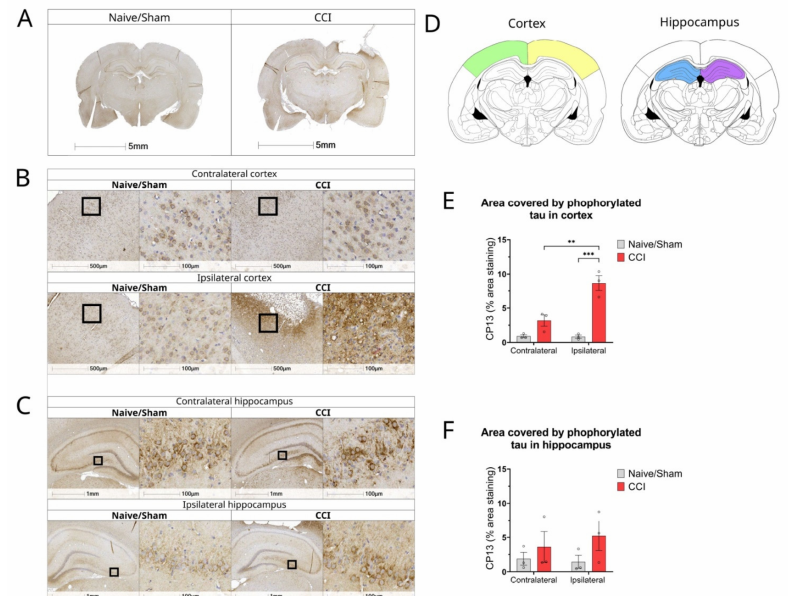
Figure 6. Tau expression is increased in cortex of CCI rat brains 2 weeks post-injury. ( A ) Rep- resentative whole brain photomicrographs of CP13 staining in naïve/control and CCI rat brains; ( B ) Magnified representative images of CP13 staining in cortex of naïve/sham animals and CCI brains from ipsilateral and contralateral sides of the injury; ( C ) Magnified representative images of CP13 staining in the hippocampus of naïve/sham animals and CCI brains from ipsilateral and contralateral sides of the injury; ( D ) Brain atlas images, showing areas of cortex and hippocampus analysed; ( E ) Quantification of CP13% area stained in the cortex of CCI and sham/naïve control rats (two-way ANOVA hemisphere F(1,8) = 14.68 p = 0.0050, injury F(1,8) = 51.38 p < 0.0001, interaction F(1,8) = 15.44 p = 0.0044); ( F ) Quantification of CP13% area stained in the hippocampus of CCI and sham/naïve control rat (two-way ANOVA hemisphere F(1,8) = 0.1271 p = 0.7306, injury F(1,8) = 2.696 p = 0.1393, interaction F(1,8) = 0.3704 p = 0.5597);. All data are presented as mean ± SEM, n = 3 per group. Two-way ANOVA, ** p < 0.01 *** p < 0.001. Mouse brain atlas images were obtained from